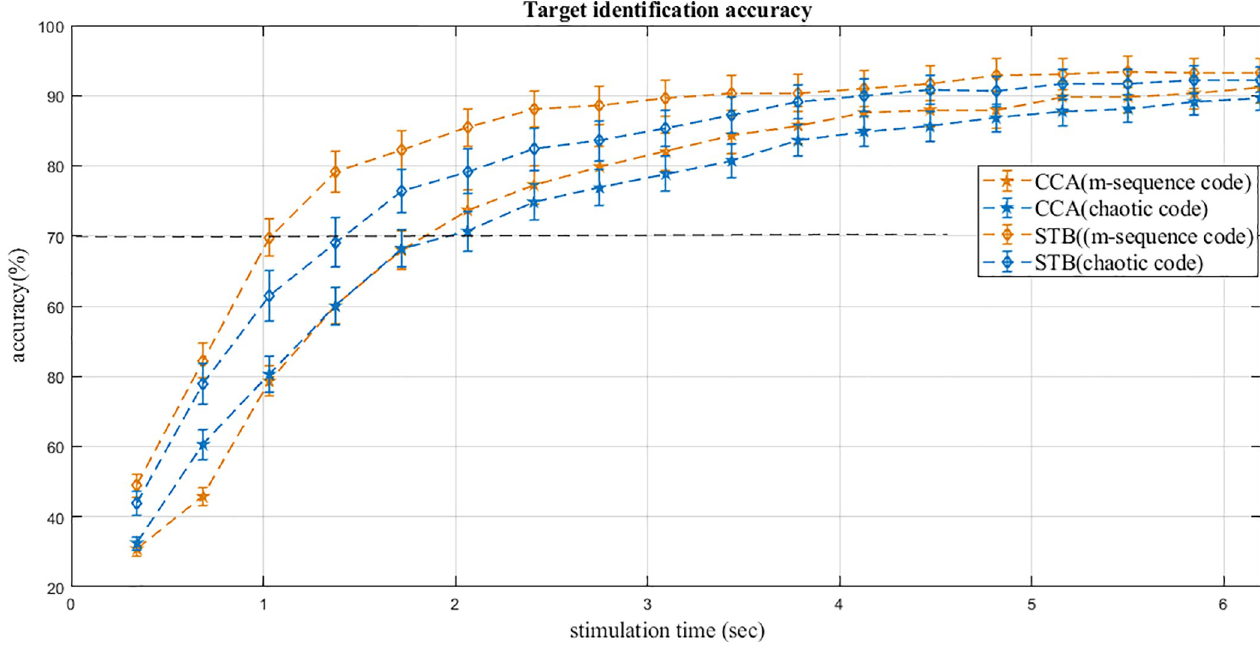
Fig 14. Accuracies of target identification for the m-sequence and chaotic codes obtained from 10-fold cross-validation with CCA and STB methods over stimulation time. Time duration for each epoch was 0.344 seconds and the total stimulation time for all 18 epochs was 6.2 seconds. The accuracy increased over stimulation time in both the methods. The dashed line shows that the STB is faster than CCA in reaching 70% accuracy.